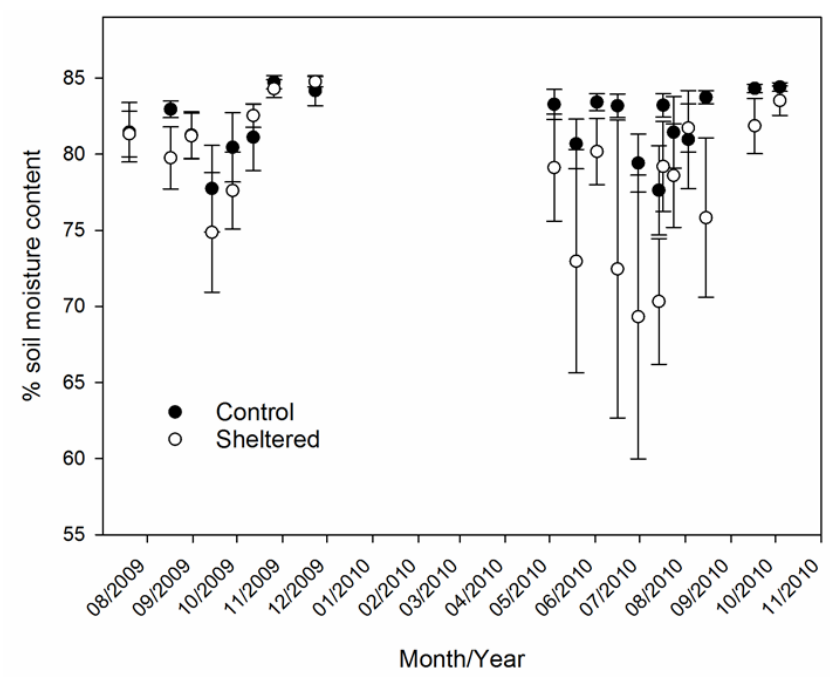
Figure 5. Mean soil moisture content (%) in control and sheltered plots (± SEM), derived from theta probe